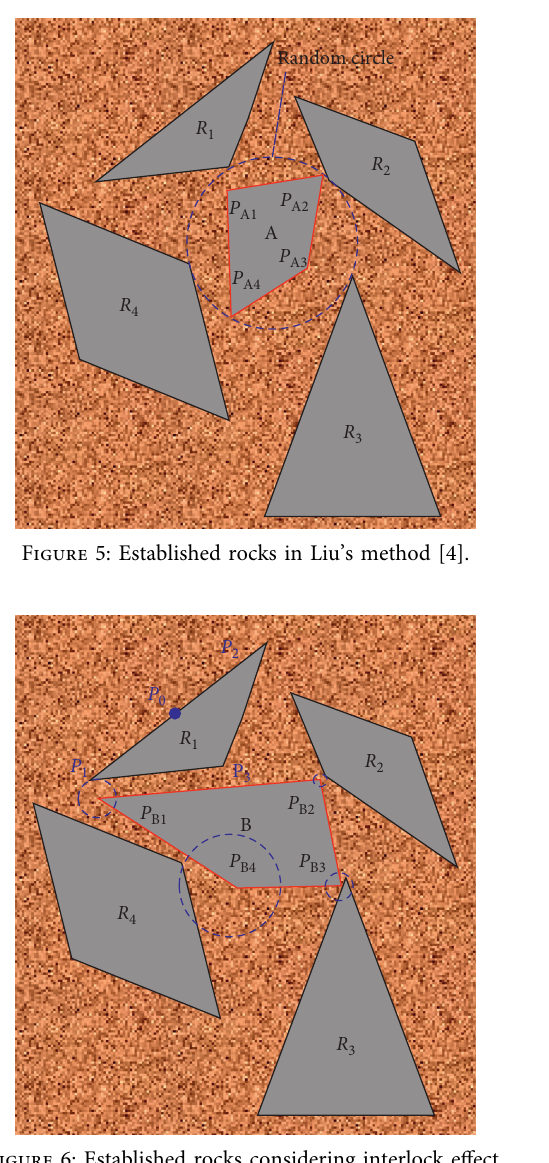
Figure 8: Rock establishment process.